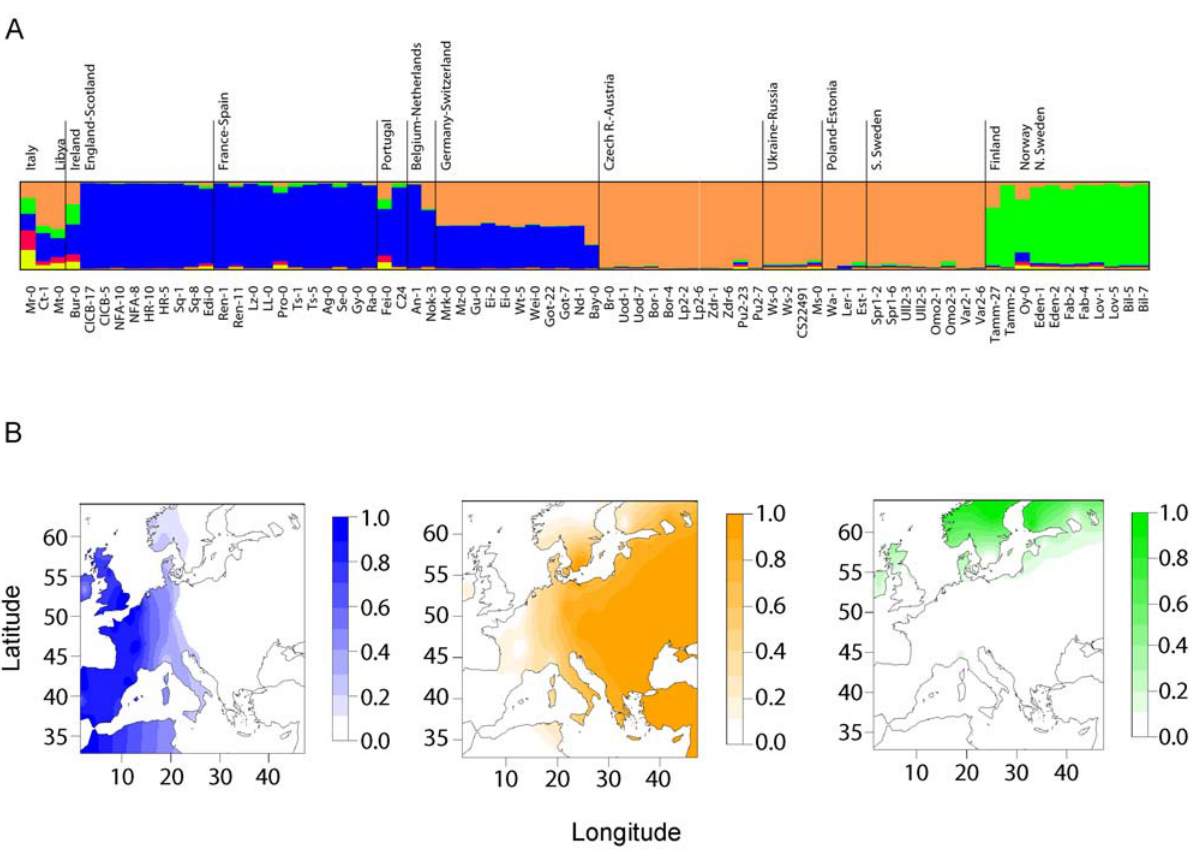
Figure 1. Bayesian clustering. (A) Membership coefficients in K max =5 putative populations, computed using the average values over the 10 TESS runs with the smallest values of the deviance information criterion from a total of 100 runs. Similar results were obtained with other values of K max from 4 to 10. (B) Interpolated membership coefficients in the three apparent subpopulations: western cluster, eastern cluster, and northern cluster.